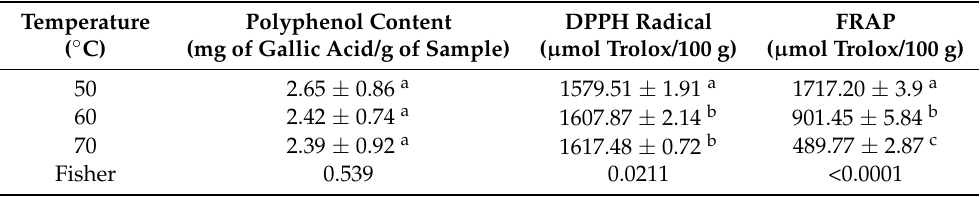
Table 5. Polyphenol content and antioxidant activity of jackfruit seed flour at the three evaluated